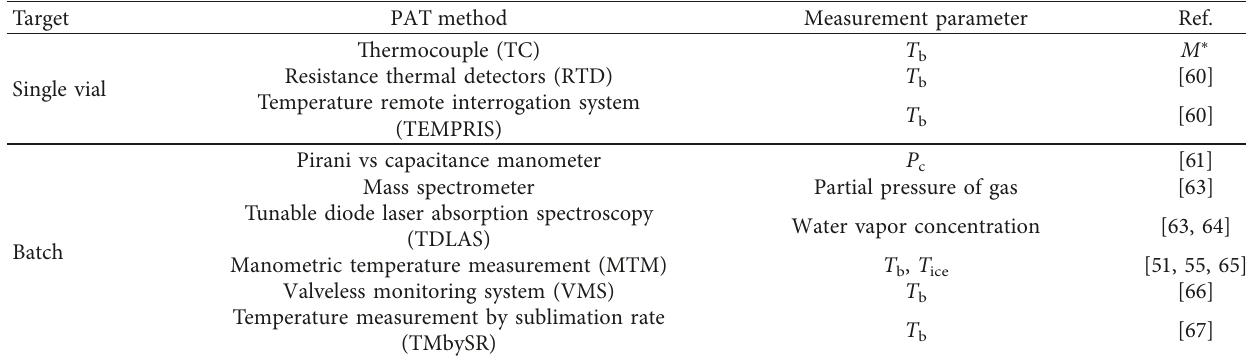
Table 3: Process analytical technology (PAT) methods in the